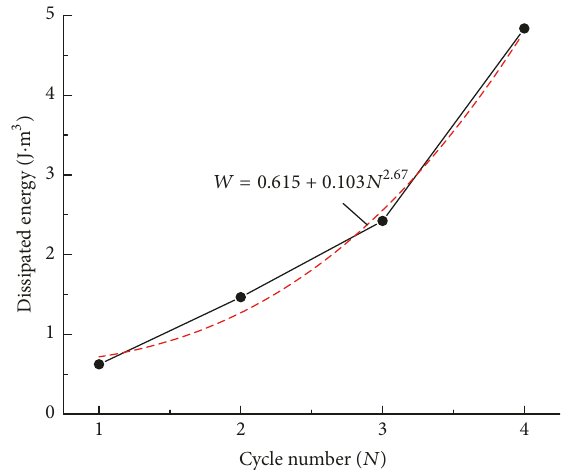
Figure 10: Relationship between the dissipated energy and the cycle number.